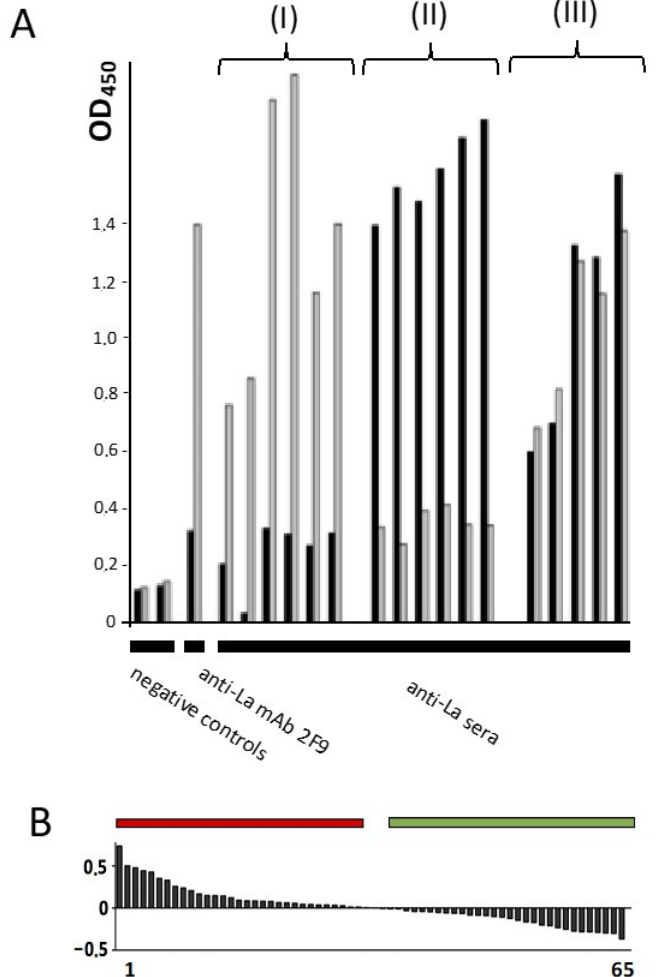
Figure 12. Comparison of the reactivity of patient’s anti-La sera against oxidized versus reduced La protein. Wild-type La protein was coated to ELISA plates. Prior to ELISA, La protein was either treated with H 2 O 2 (black bars) or DTT (gray bars). Oxidoreduction was verified by the anti-La mAb 2F9. ( A ) Tested sera were grouped into three categories: (I) sera, which preferentially react with the reduced form of La protein, (II) sera, which preferentially react with the oxidized form of La protein, (III) sera, which do not show major differences in dependence on oxidoreduction. ( B ) Until now, 64 anti-La positive patient sera were tested for a differential reactivity to either the oxidized or reduced form of La protein. The sera were sorted for their preferential reactivity against either the oxidized (red bar) or reduced form of La protein (green bar). Each black bar represents one serum.